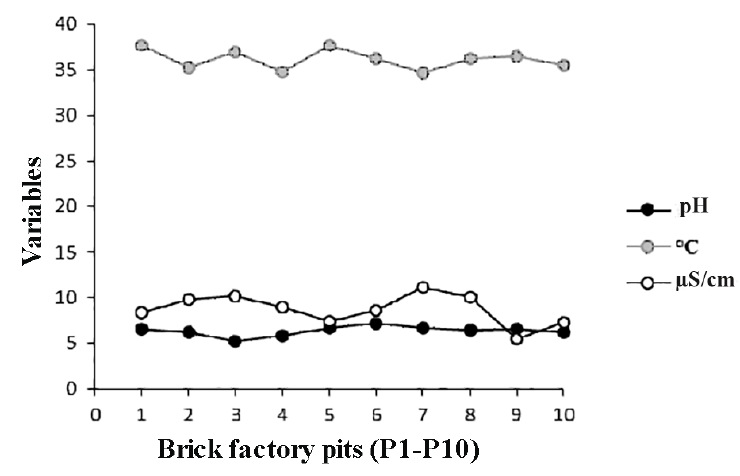
Figure 3. Physical and chemical parameters of pre-application in the clay pits (P1-P10), Km 2 at the AM 070, Iranduba,